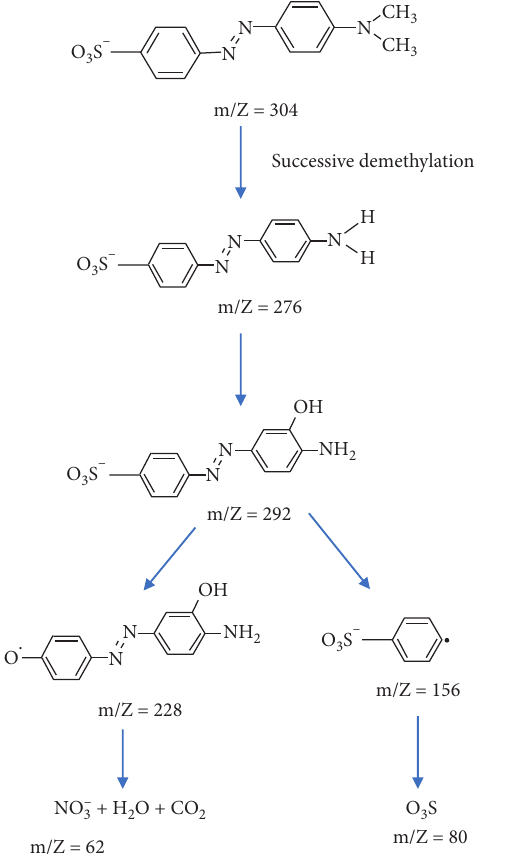
Figure 28: Proposed mechanism of methyl orange degradation according to Nagar and Devra, 2019.